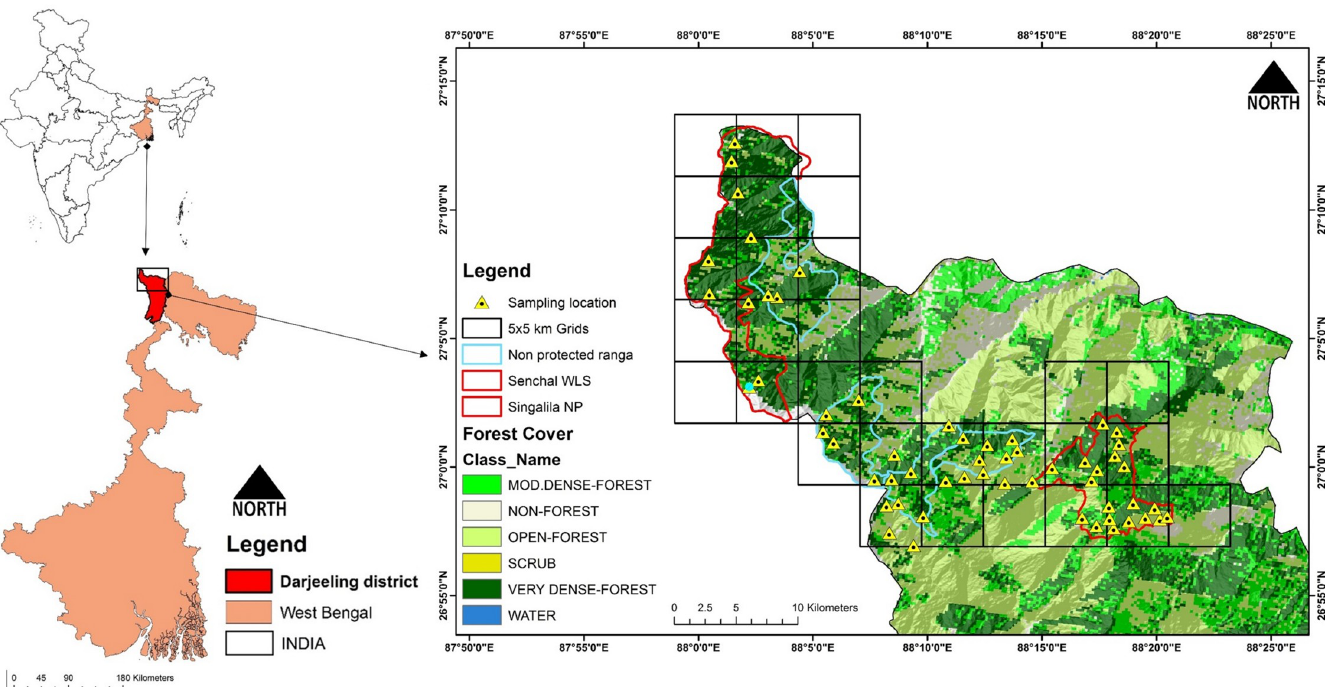
Fig 1. Study area map depicting camera trap locations in protected and non-protected forest ranges of Darjeeling district, West Bengal. WLS, Wildlife Sanctuary; NP, National Park; Non-PAs, Non Protected areas. (Maps are generated using ArcGIS 10.6 www.esri.com).